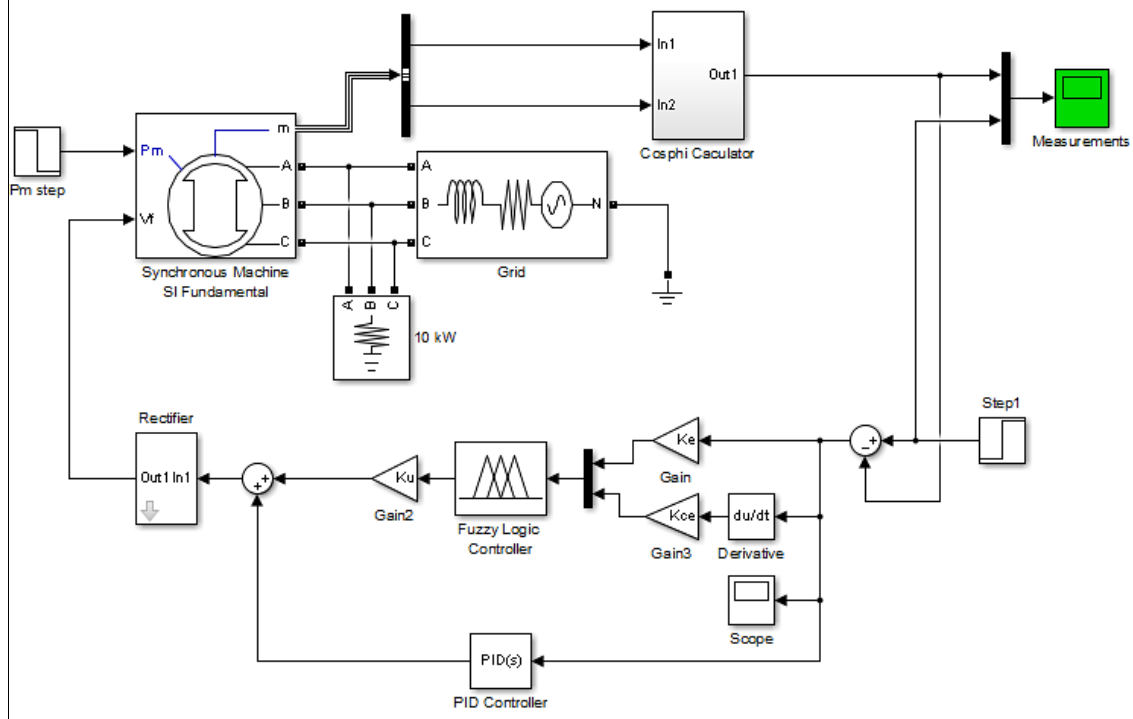
Figure 15. Control system on